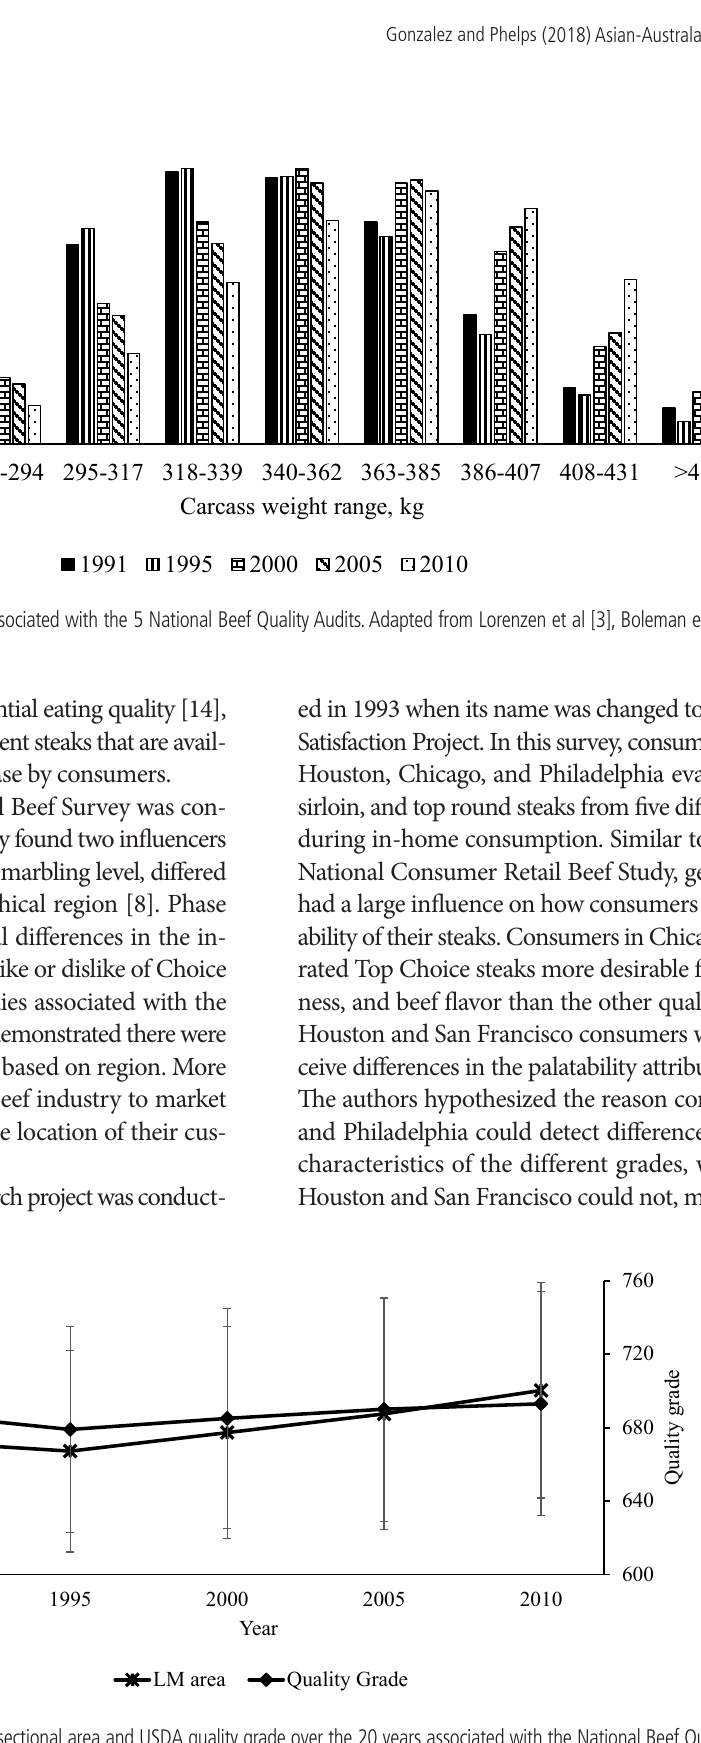
Figure 2. Increases in Longissimus muscle cross-sectional area and USDA quality grade over the 20 years associated with the National Beef Quality Audits. Adapted from Lorenzen et al [3], Boleman et al [4], McKenna et al [5], Garcia et al [6], and Moore et al [7].